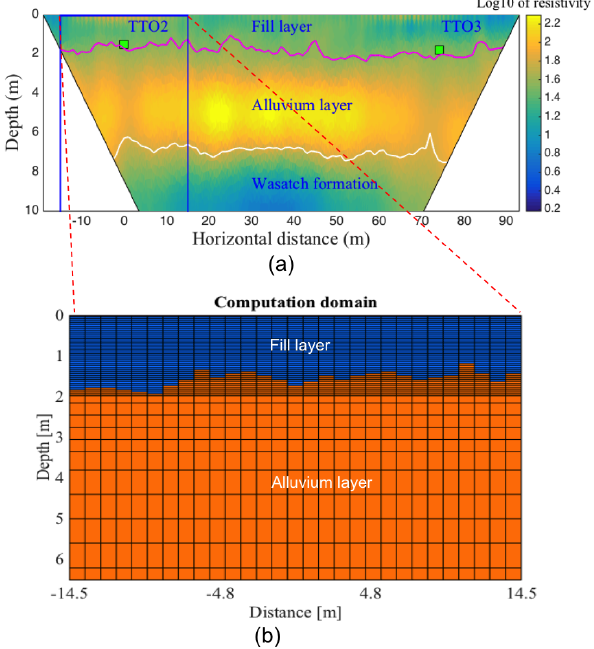
Figure 3. (a) The 2-D image of the soil electrical resistivity ob- tained by inverting ERT data collected on 20 May 2013. The magenta and white lines delineate the inferred fill–alluvium and alluvium–Wasatch boundaries, respectively. Green square markers denote the fill–alluvium boundary determined from the well logs of TT02 and TT03 and adjacent wells, as recorded in the field dur- ing drilling. The blue rectangular box indicates the hydrological- thermal computational domain. (b) Computational domain for the hydrological-thermal inversion with associated grid mesh. Blue and orange regions represent the fill and alluvium layers, respectively. The domain is situated below an atmospheric layer (top boundary) and above the relatively impermeable Wasatch (bottom